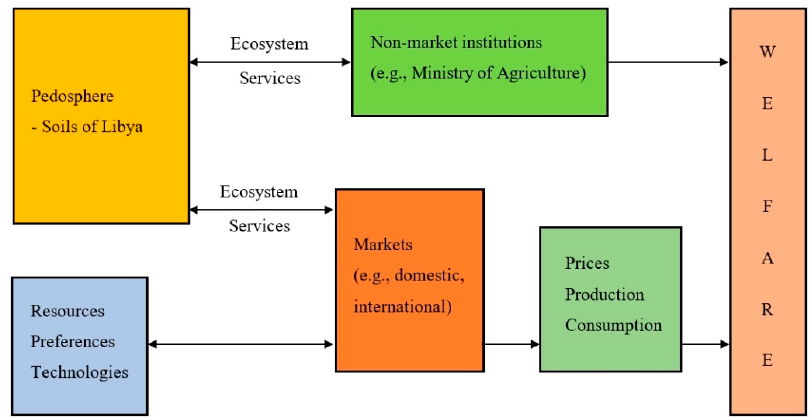
Figure 3. A conceptual diagram for Libya of how market and non-market institutions can potentially transform soil resources into goods and services that meet the population demand (adapted from [29]).